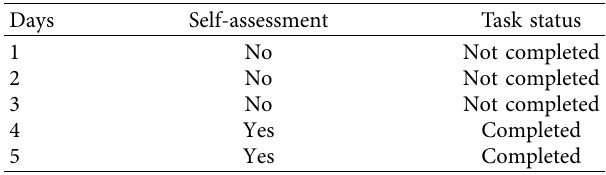
Table 6: Effect of self-assessment on task completion.